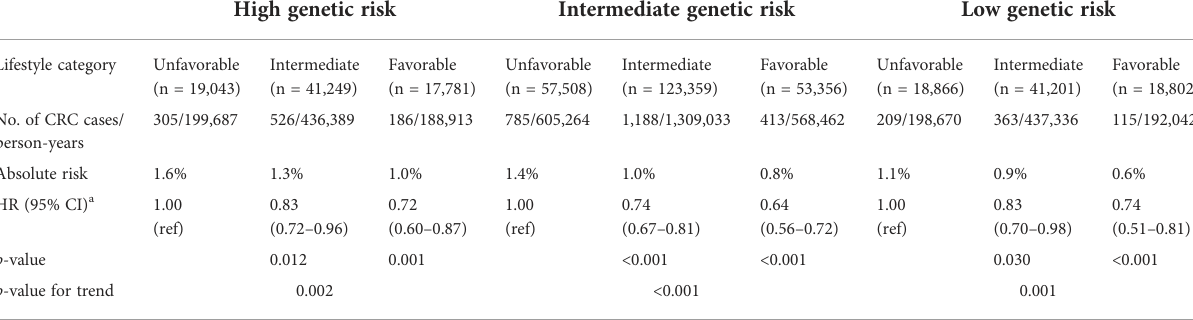
TABLE 4 Risk of CRC according to lifestyle category within each PRS category.